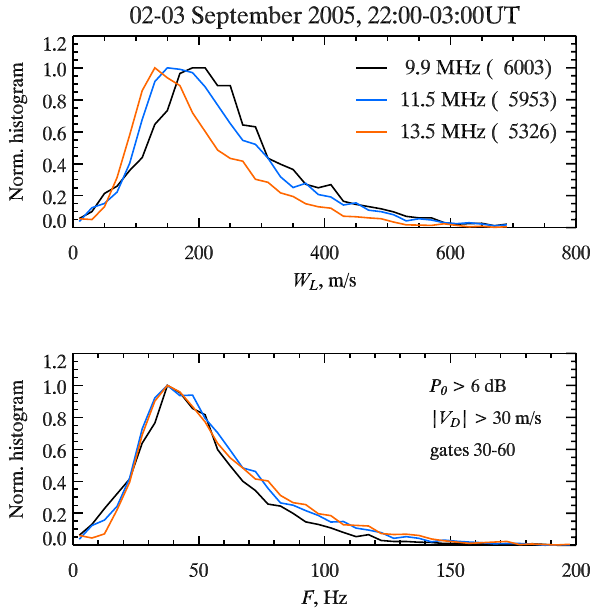
Fig. 5. Spectral width histograms for the data enclosed by the red rectangles in Figs. 2–3. The top panel presents width measured in m/s, W , while the bottom panel shows the same data but in Hz, F . The numbers in brackets are respective numbers of processed ACFs for each radar